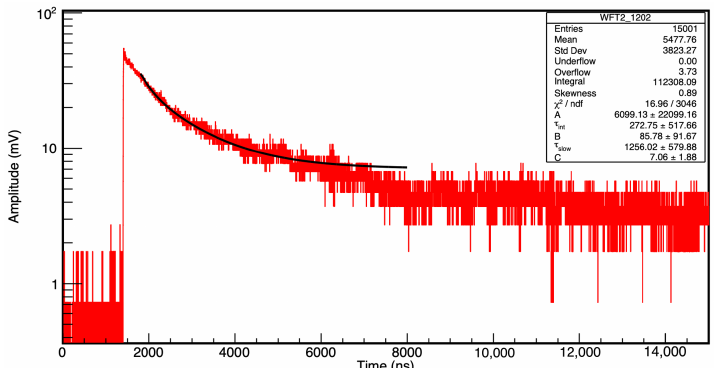
Figure 4. The average waveform of the cosmic muon signals and the fit to the sum of two exponentials and a